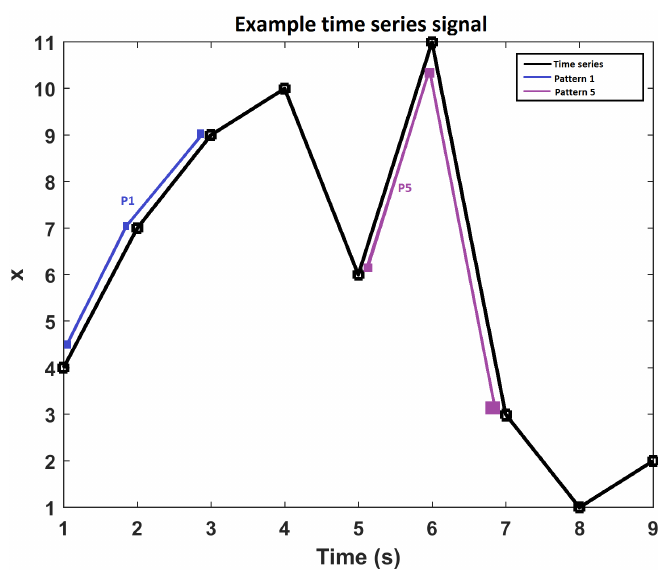
Figure 3. Example of pattern mapping/identification in a time